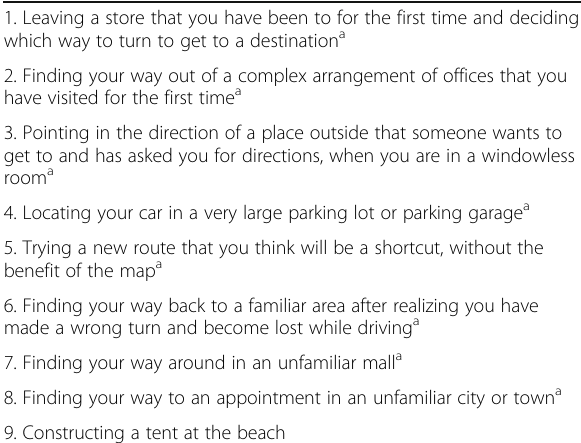
Table 1 Initial Modified Spatial Anxiety Scale (M-SAS)